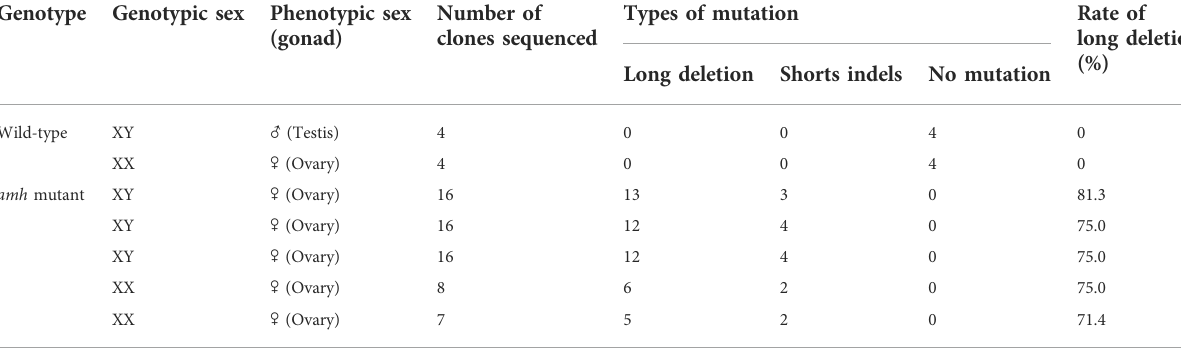
TABLE 5 Genotypic and phenotypic sexes in juveniles of P. olivaceus and the types and frequencies of amh mutations in each individual.